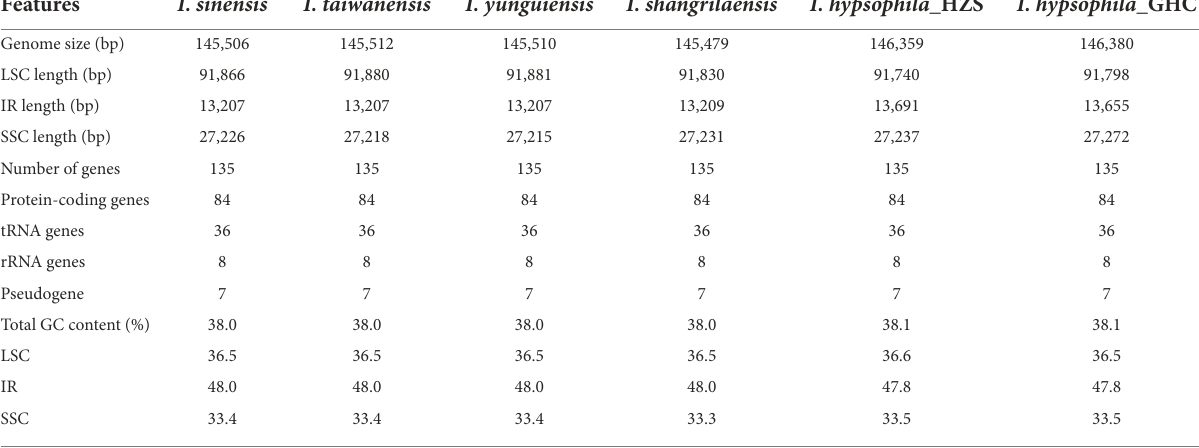
TABLE 1 The basic characteristics of the chloroplast genomes of six Isoetes